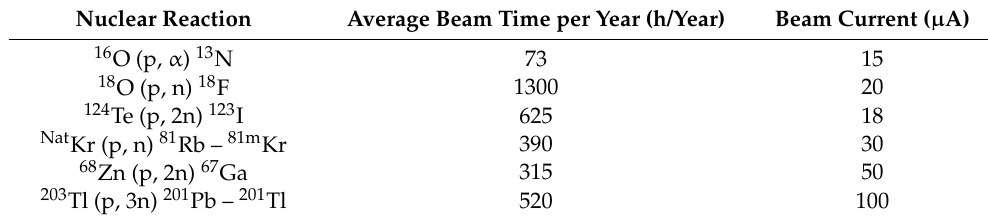
Table 2. List of CS-30-produced PET and SPECT isotopes.